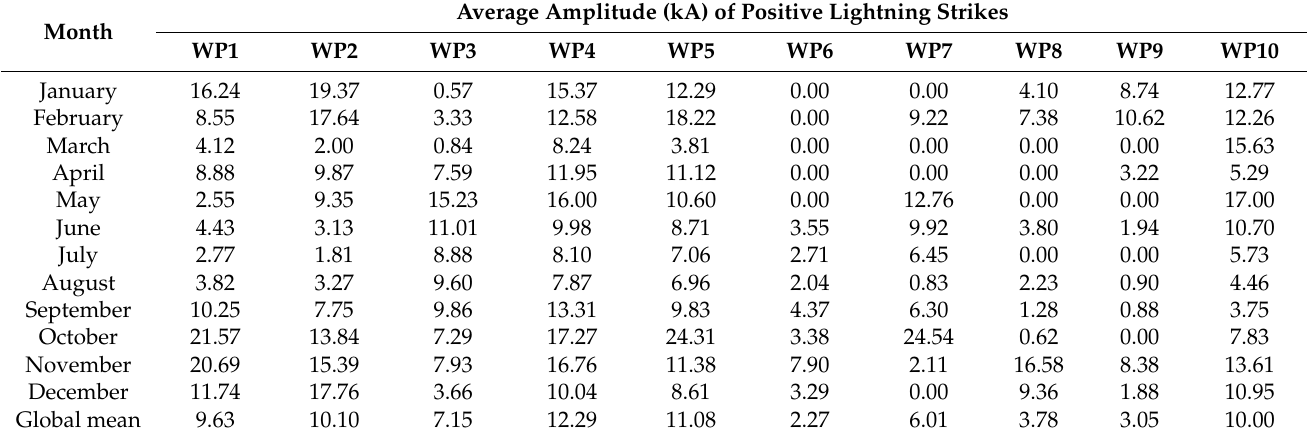
Table A3. Of the recorded positive lightning strikes per wind park.